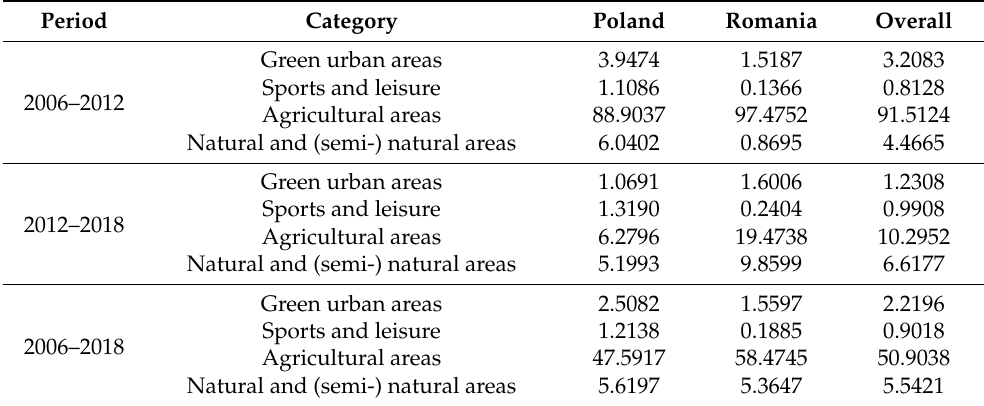
Table 4. Overall loss of different categories of GI categories across the two periods and counties in Romanian and Polish cities covered by Urban Atlas data. The table displays the average share of each category in the total loss of GI.